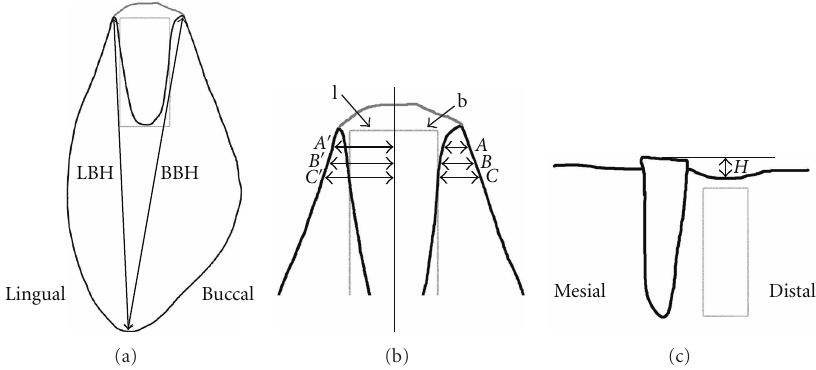
Figure 3: Schematic drawing representing the locations of the morphometric measurements performed in this study with the grey rectangle showing the approximate shape and place of the sca ff olds/shams. (a) Vertical parameters: buccal bone height (BHH) and lingual bone height (LBH). For sca ff old and sham sites, a straight line was drawn along the edges of the sca ff old/sham, and bone height was measured where this line intersected the bone crest. In addition, the vertical height di ff erence between buccal and lingual bone crest was measured (lines b and l in (b)). (b) Horizontal parameters: buccal and lingual alveolar wall width ( A , B , C ) and buccal and lingual total bone width ( A (cid:3) , B (cid:3) , C (cid:3) ) 1, 3, and 5mm apical of the buccal and lingual bone crest, all measured perpendicular to the long axis of the defect. (c) Vertical bone loss: di ff erence in height ( H ) between original bone level and bone level at defect site after six weeks of healing.